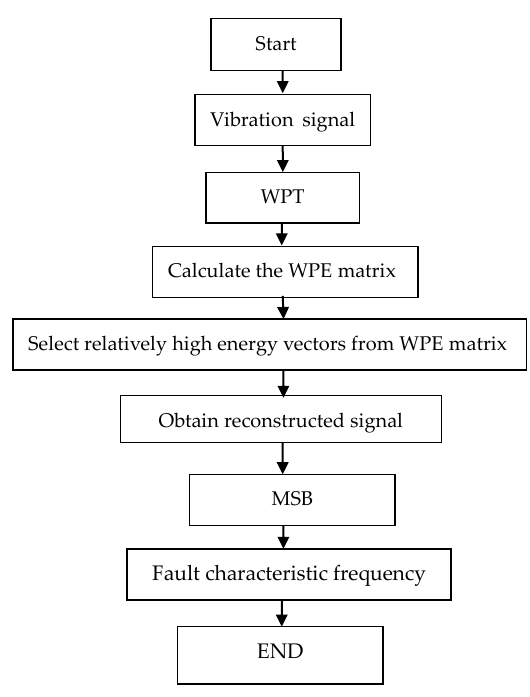
Figure 1. Flowchart of the proposed method.